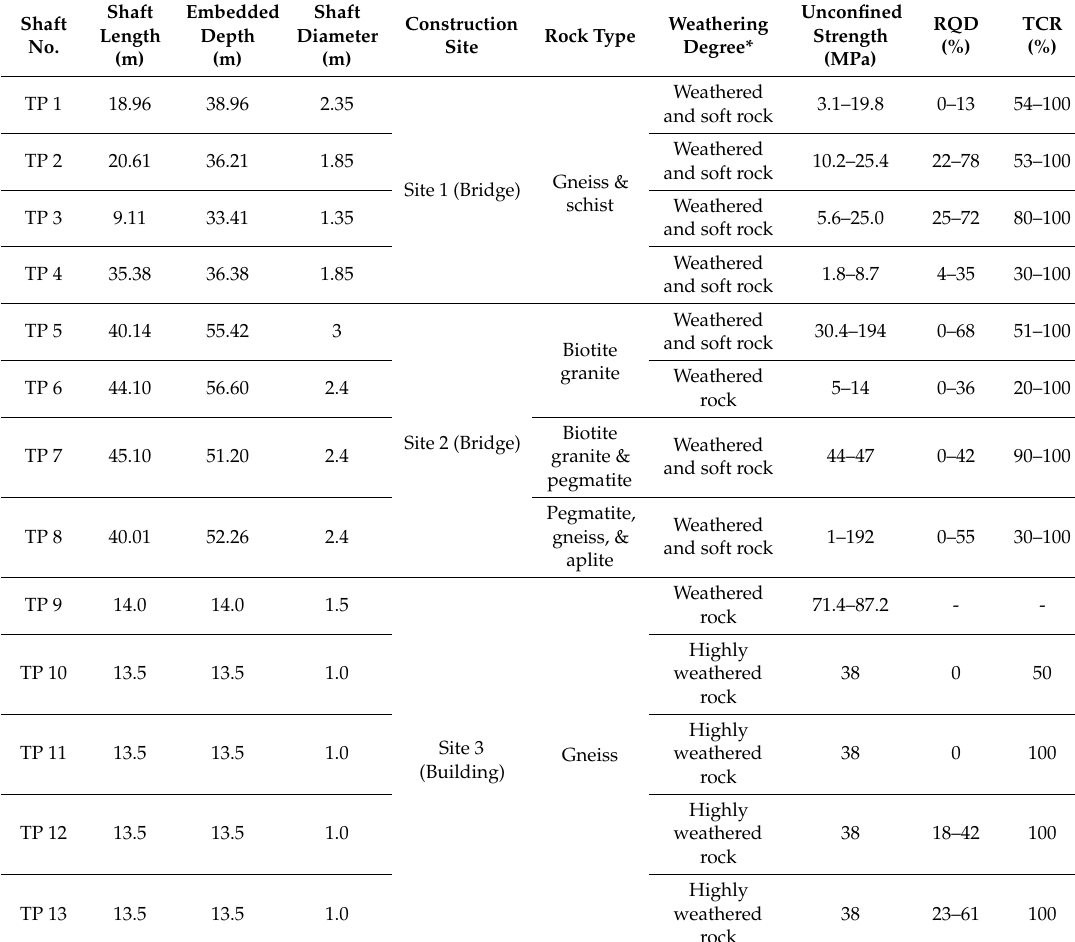
Figure 3. Site investigation results (Site 3). Table 1. Test shaft profile and site investigation results.